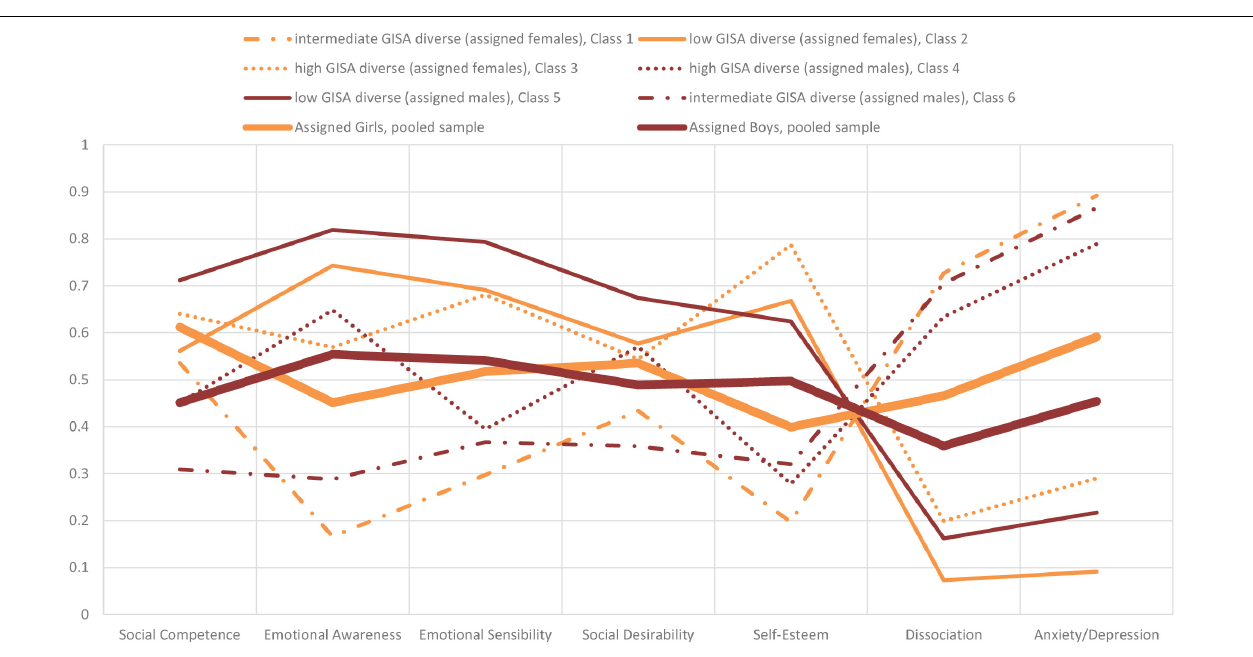
state for the “low GISA diverse” in class 5 (37.9%) and “high GISA diverse” in class 3 (8.3%; see Table 1